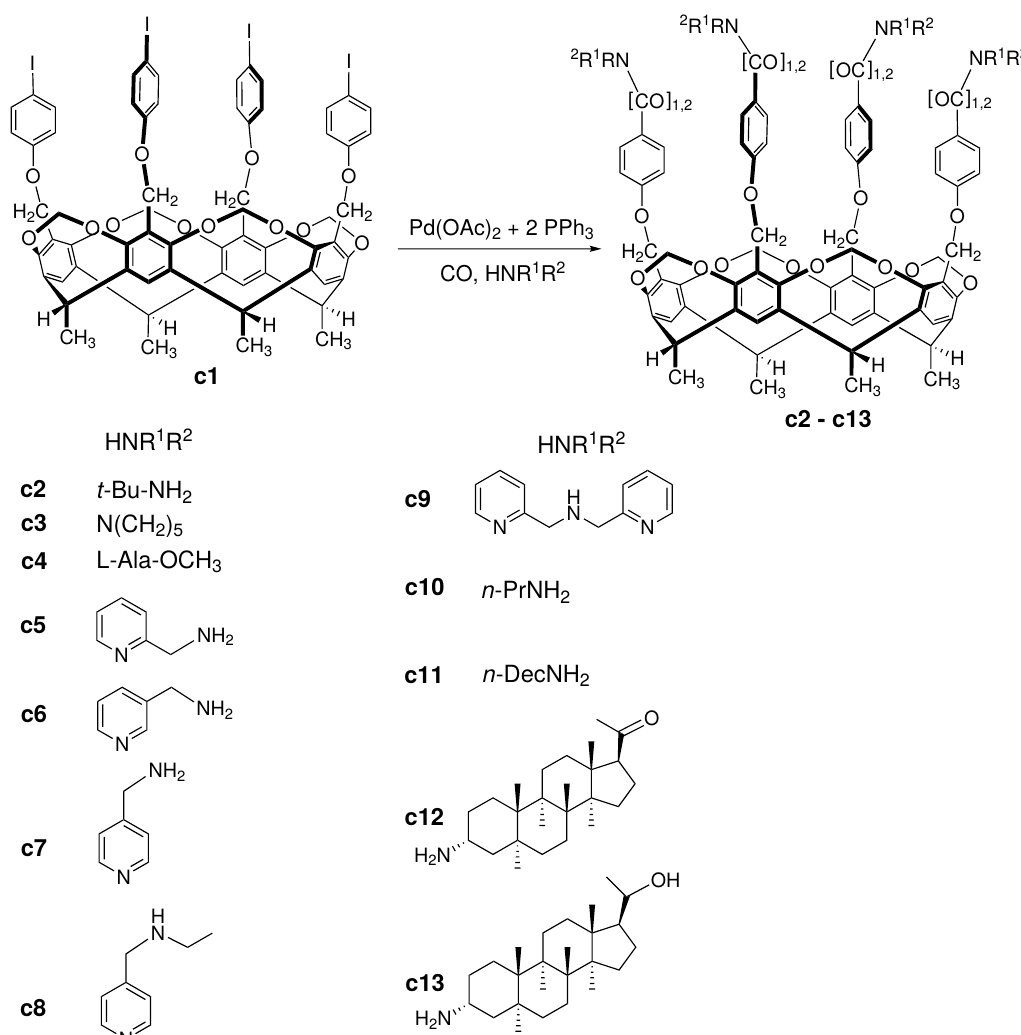
Figure 19. Scheme of the aminocarbonylation reaction on cavitand scaffold.